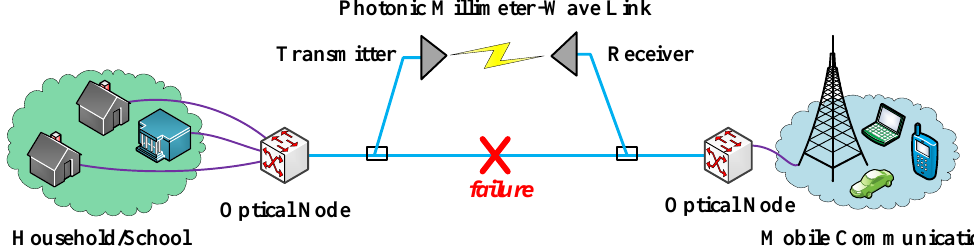
Figure 4. The photonic millimeter-wave bridge scheme.